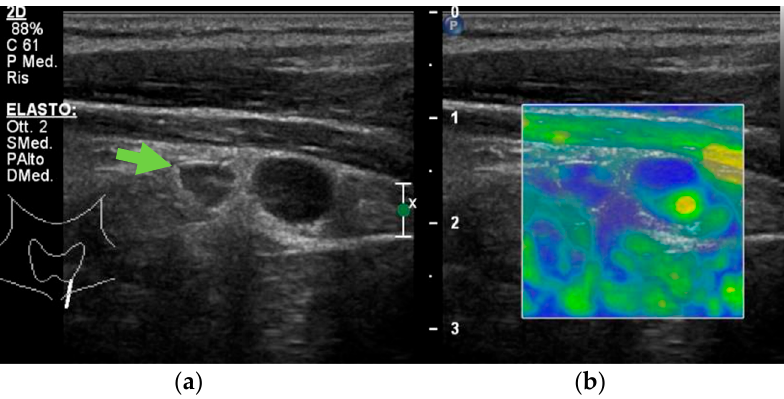
Figure 2. Grey-scale ( a ) and elastography ( b ) aspect of a hyperplastic parathyroid gland (arrow).